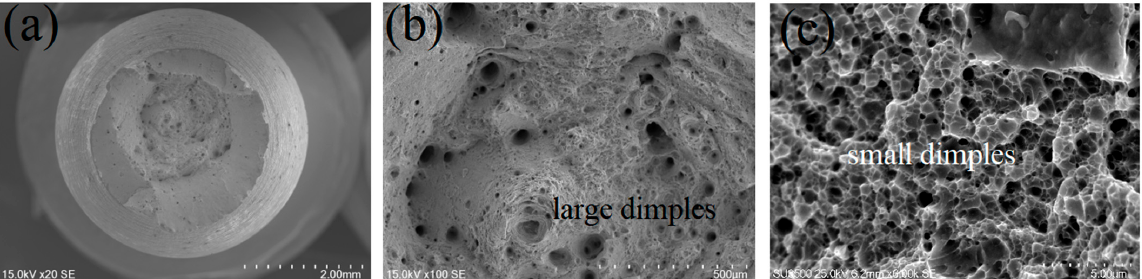
Figure 9. Fracture morphology of the SLM sample. (( a ) fracture morphology, ( b ) fiber area, ( c ) a high magnification of the lip shearing).